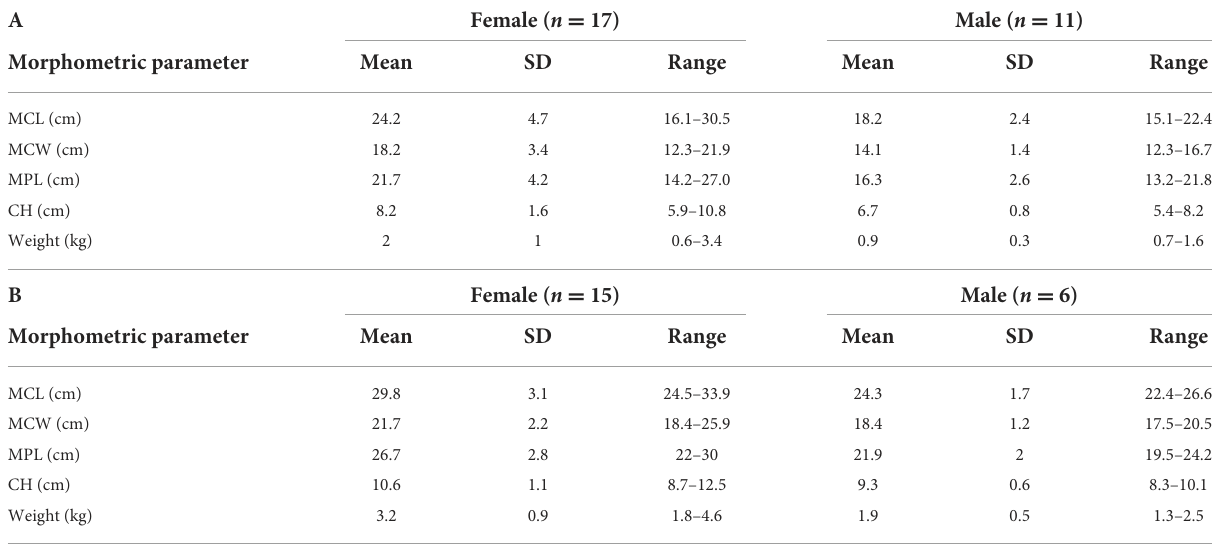
TABLE 1 Savannah side-necked turtle ( P. vogli ) and Yellow-spotted river turtle ( P. unifilis ) morphometric